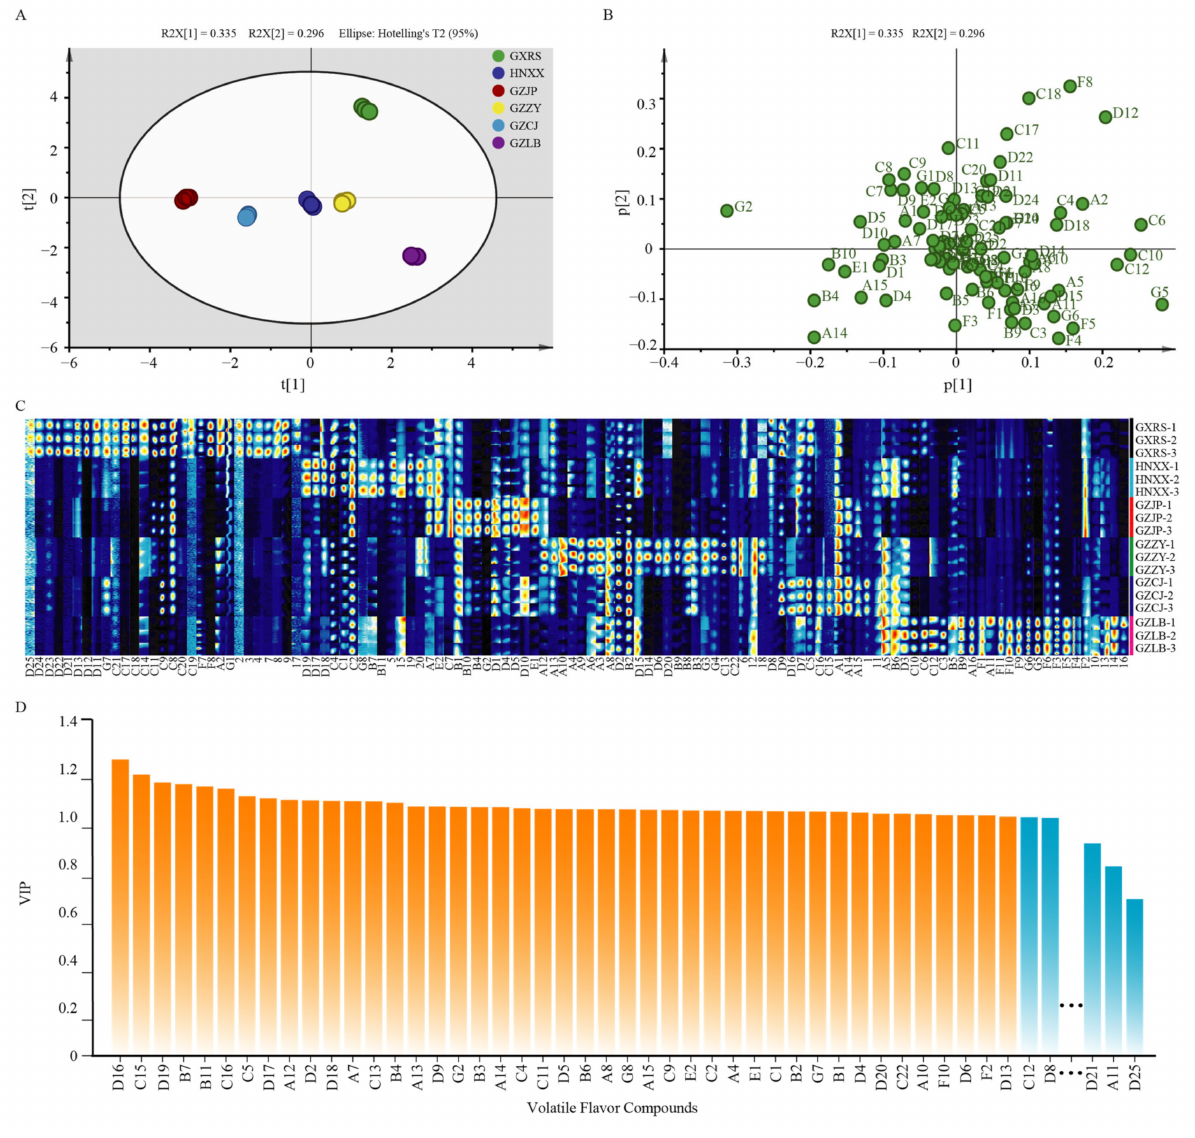
Figure 4. Volatile organic compounds analysis of SR from different regions. ( A ) Principal compo- nent analysis (PCA) and ( B ) load diagram results for flavor metabolite contents in SZR samples. ( C ) Gallery Plot of SR from different regions. Each line in the figure represents all signal peaks selected from a sample. The brighter the color is, the stronger the signal is, and the darker the color is, the weaker the signal is. ( D ) The variation of VIP (pred) values of VOCs in SR samples from different regions. Orange indicates VOCs with VIP > 1 and blue indicates VOCs with VIP < 1. All the VOCs with VIP > 1 and part of the VOCs with VIP < 1 are shown in the